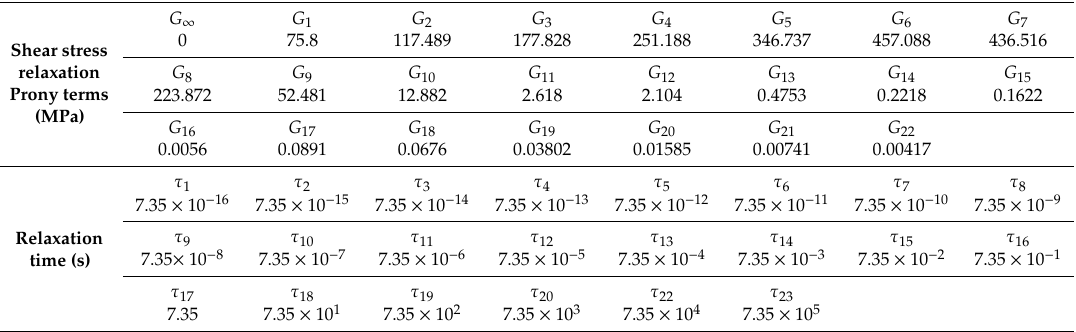
Table 1. Relaxation and shear Prony terms for Estane